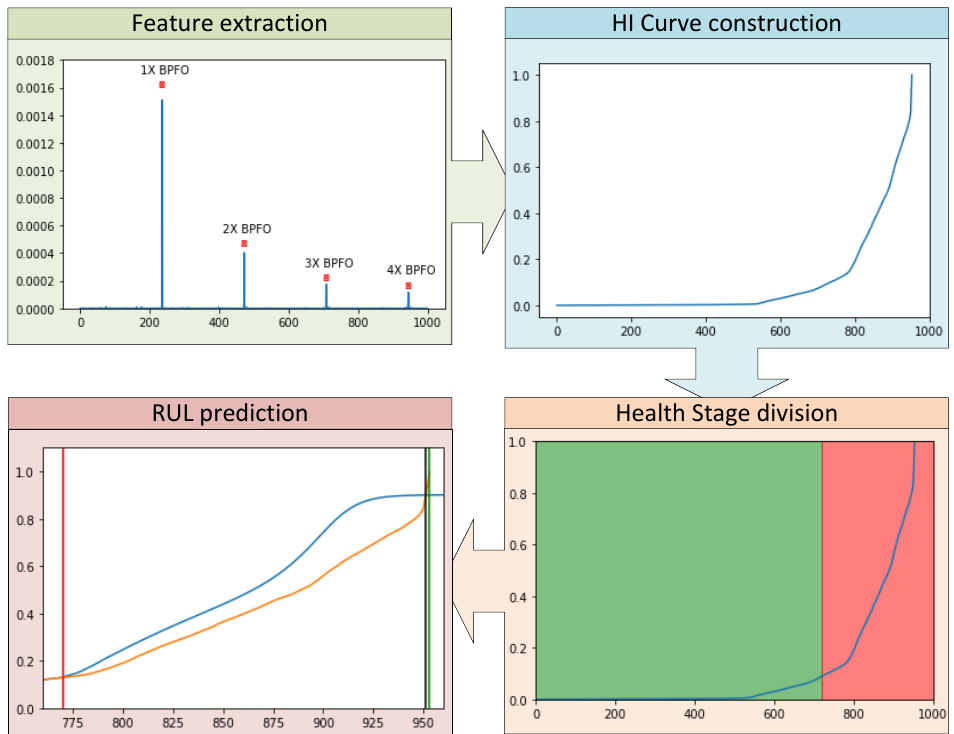
Figure 1. Proposed Solution: feature extraction, HI curve construction, health stage division, and RUL